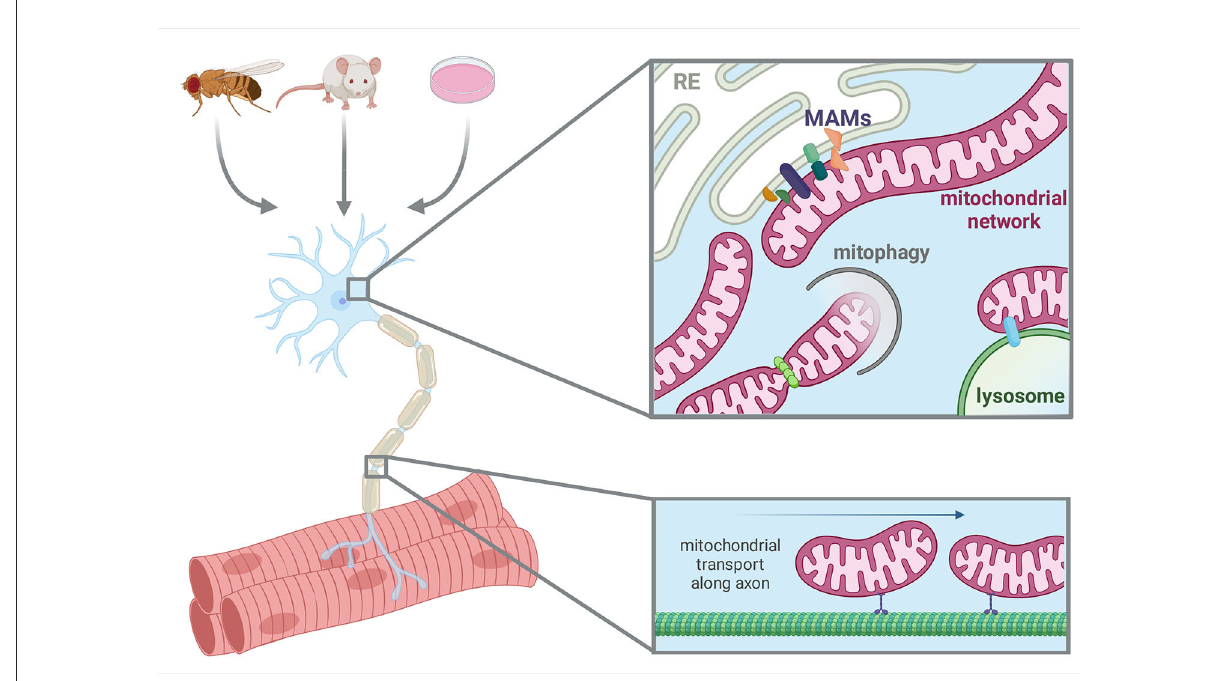
FIGURE1 Model systems utilized and aspects of neuronal mitochondrial biology in this Research Topic. Created with